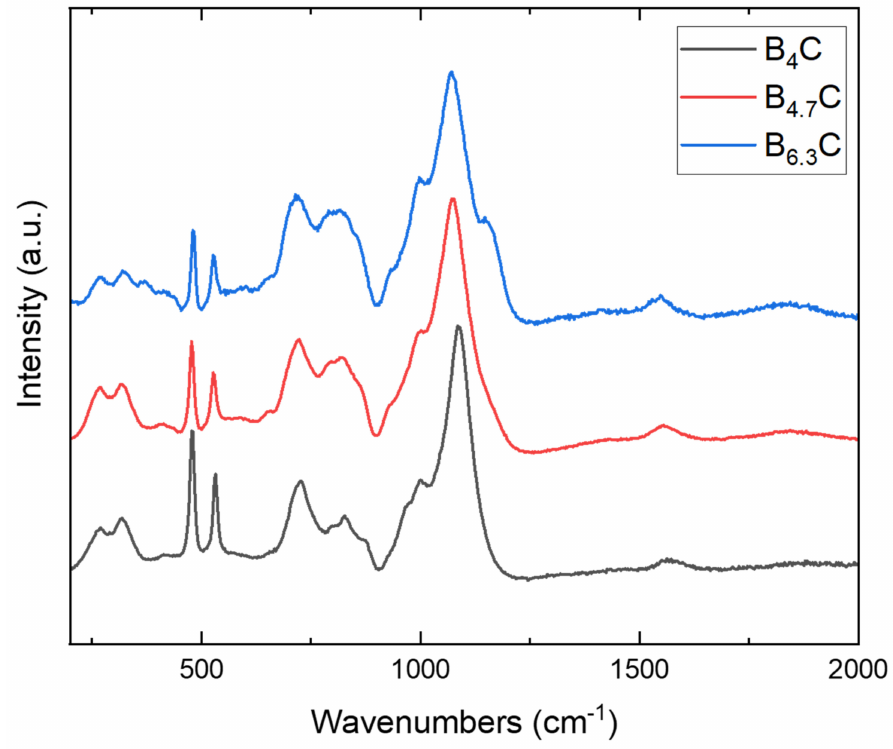
Figure 1. Raman spectra of pristine boron carbide samples, B 4 C, B 4.7 C, and B 6.3 C, used in this study. In virgin surface measurements, no prominent peaks are seen past 1200 cm − 1 , where amorphous